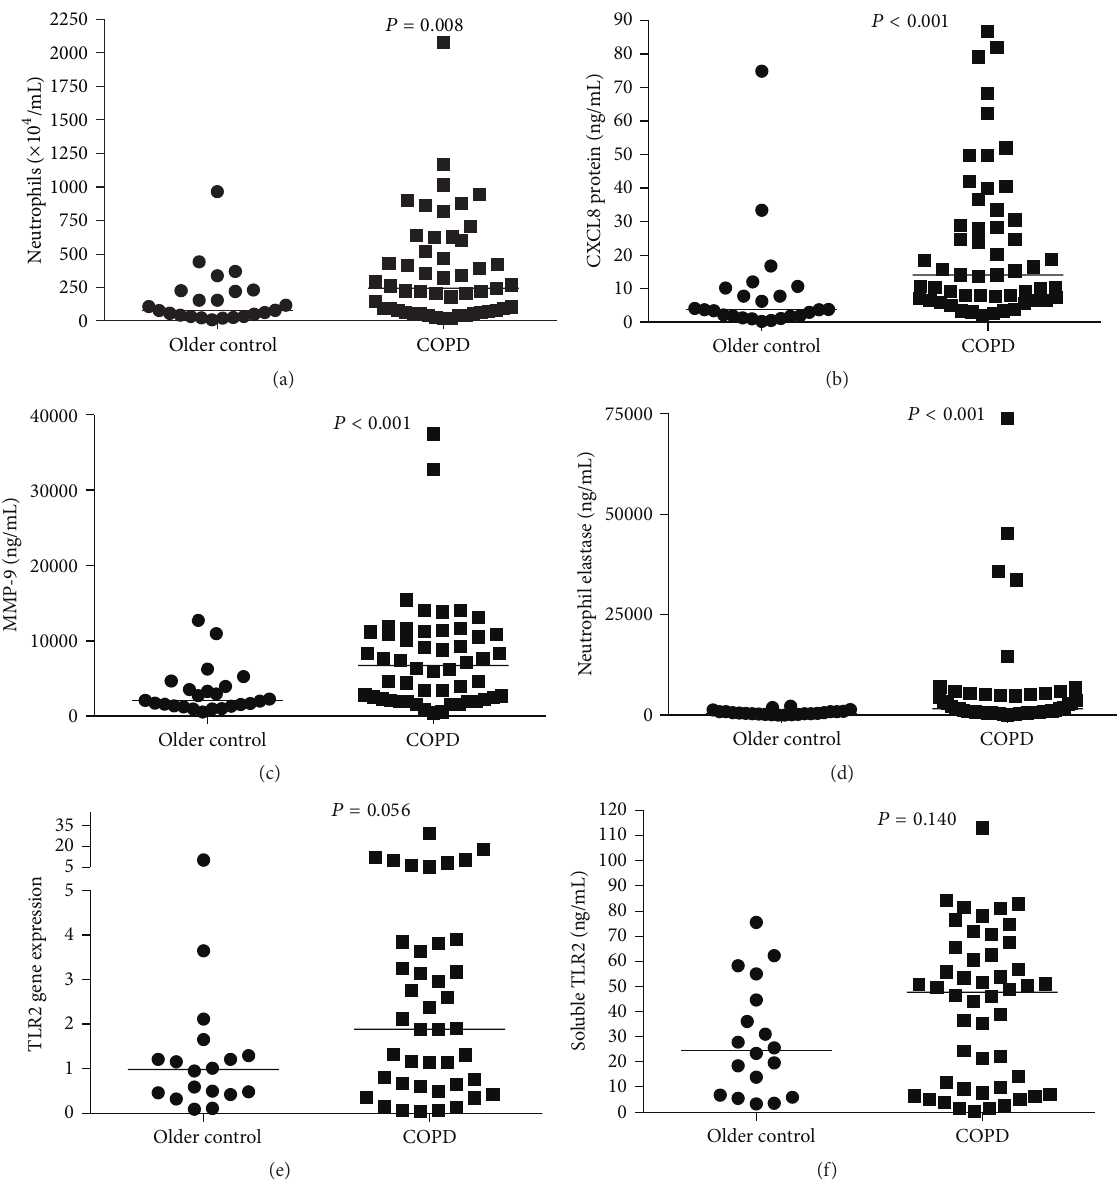
Figure 3: Analysis of the effect of the presence of airflow obstruction on markers of neutrophilic inflammation. This analysis compared older healthy controls with participants with COPD. (a) Neutrophil number × 10 4 /mL, (b) CXCL8 protein ng/mL, (c) MMP-9 protein ng/mL, (d) NE protein ng/mL, (e) TLR2 gene expression, and (f) soluble TLR2